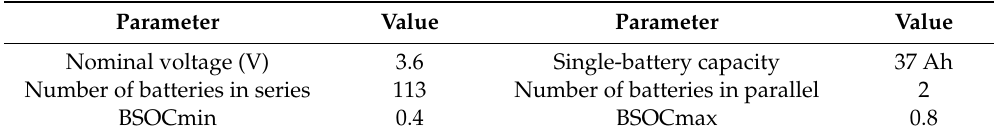
Table 6. Power battery